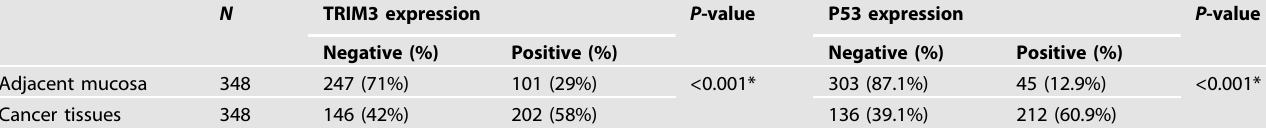
Table 1. Expression of TRIM3 and P53 in adjacent non-cancerous mucosa and cancer